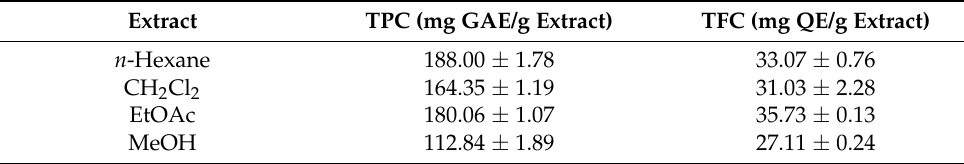
Table 2. The TPC and TFC values of G. celebica root bark